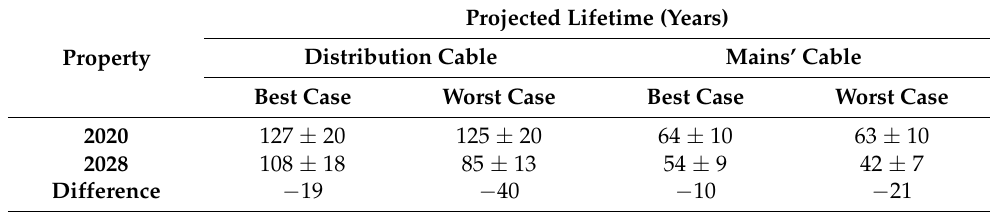
Table 8. Lifetime prediction changes (years) for 2020 and 2028, considering ± 5% ambient temperature